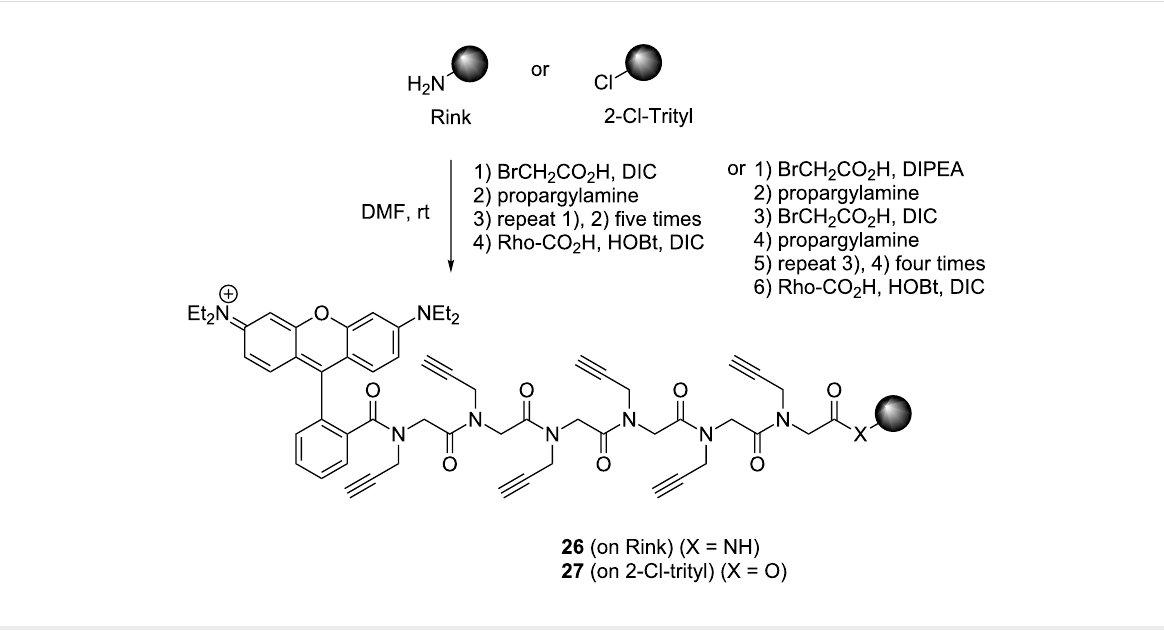
Scheme 3: Synthesis of hexaalkynyl peptoids 26 and 27 on solid